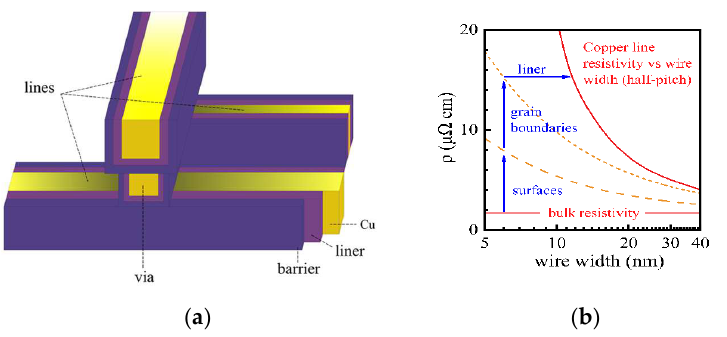
Figure 2. ( a ) Schematic of the interconnect structure. Two layers of horizontal metal lines are connected vertically by via. Barrier and liner are indicated. ( b ) The resistivity of Cu interconnects wire versus wire width. Reprinted with permission from ref. [7]. Copyright 2021, Springer Nature.